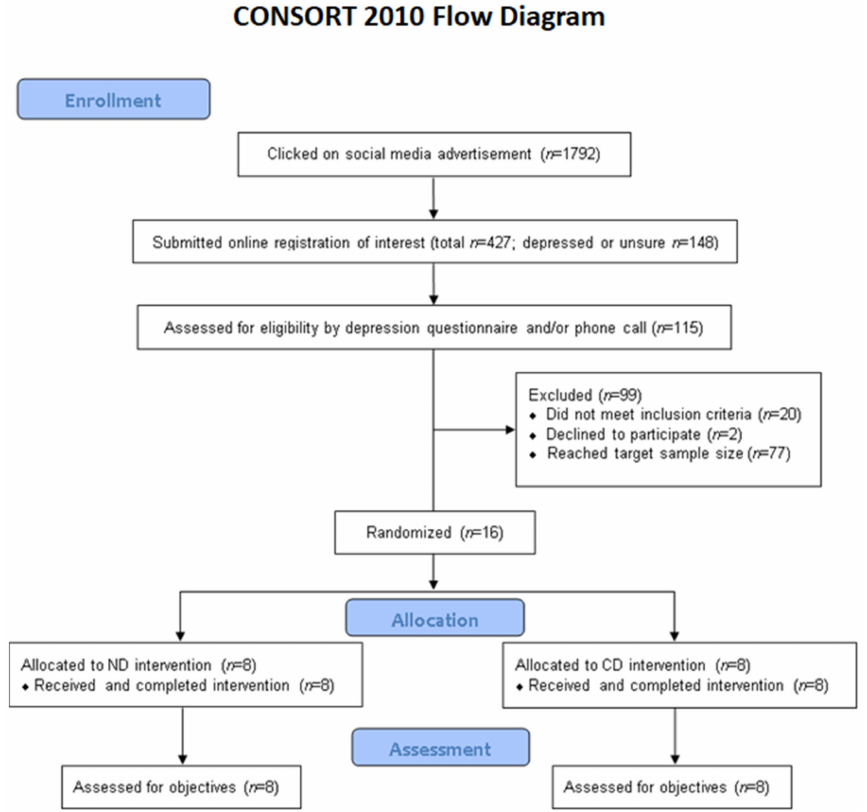
Figure 1. Consolidated Standards of Reporting Trials (CONSORT) flow